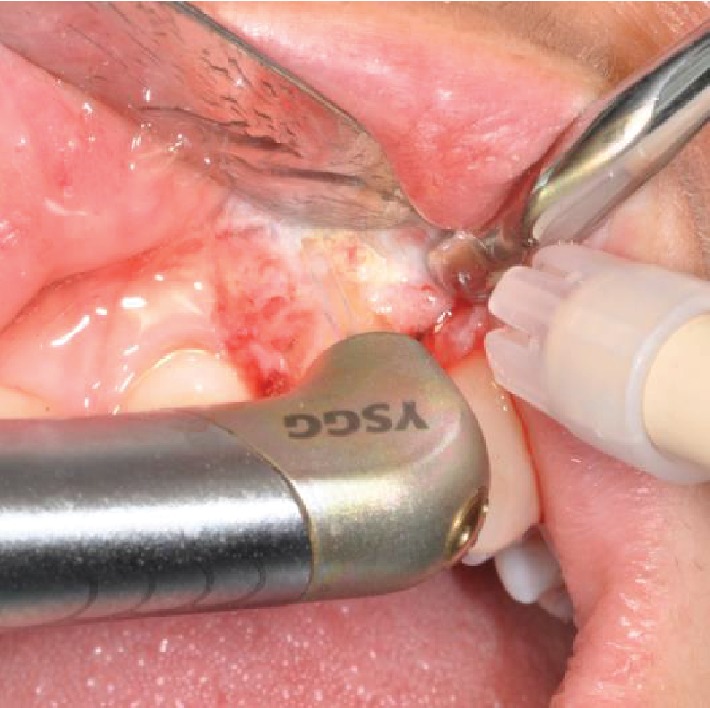
Phases of surgery.